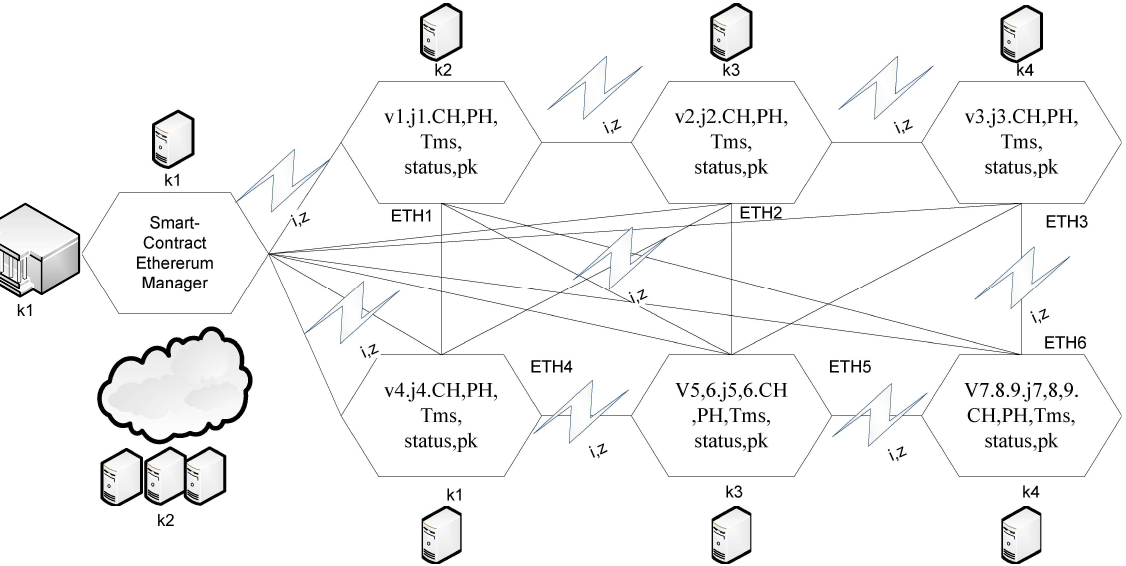
Figure 3. Smart-Contract Ethereum Mechanism in Distributed Client-Fog-Cloud.